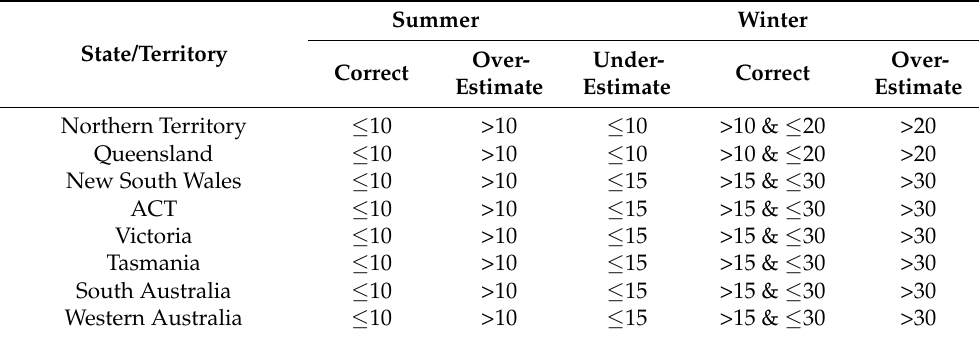
Table 1. Definition of knowledge of time outdoors 1 (in minutes) needed to maintain adequate vitamin D in summer and